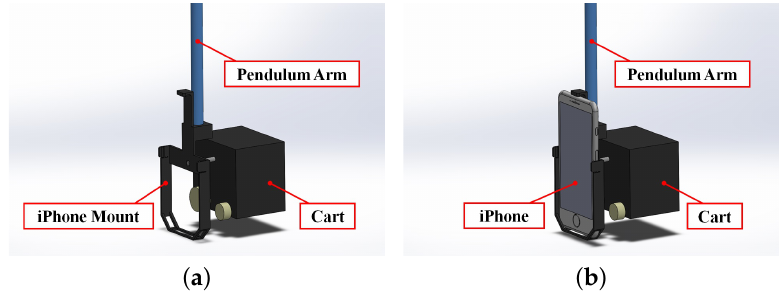
Figure 5. Design of a mount for the IPC system ( a ) without and ( b ) with a smartphone secured.